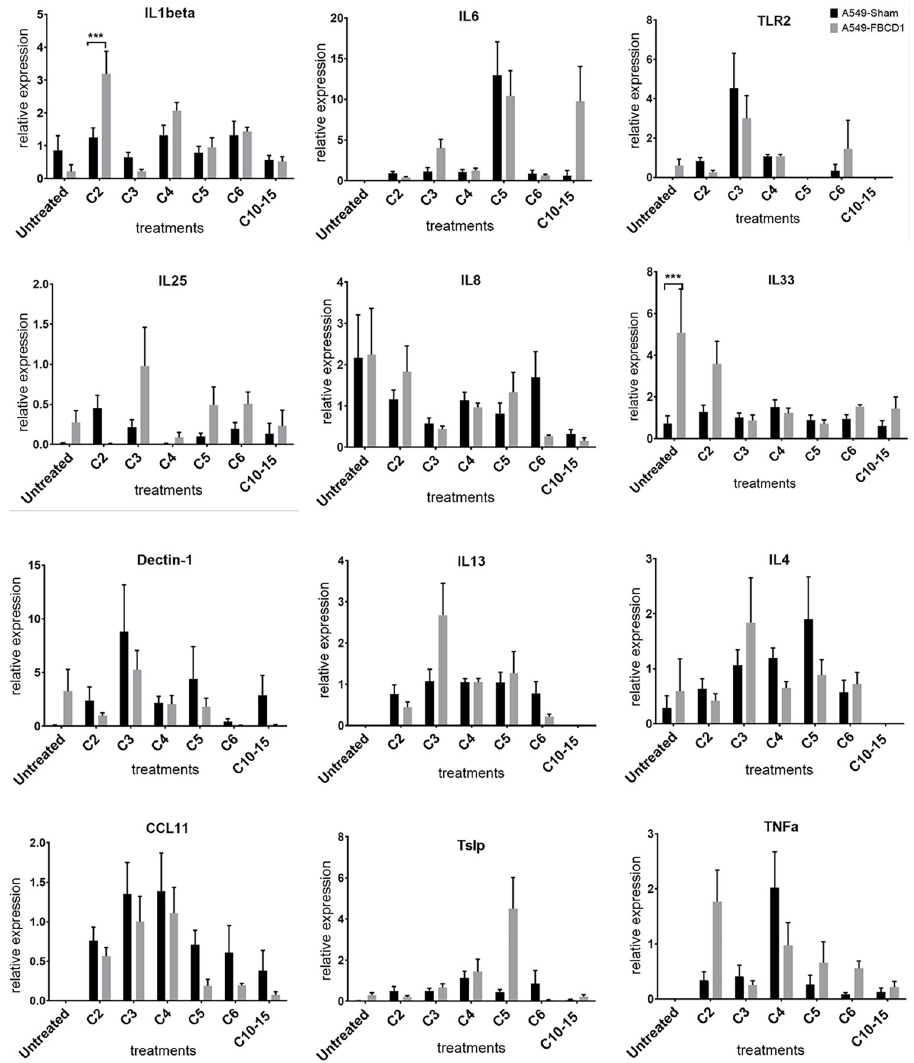
Fig 1. Cytokine modulation in human lung epithelial cells over-expressing FIBCD1 in response to chitin fragments of different sizes. A549-Sham transfected cells are used as control. Cells stimulated for 6 hours and harvested as described in materials and methods and analyzed by qRT-PCR for expression of indicated cytokines using ΔΔ Ct method. Data are a summary of two-three experiments. n = 12/group. � p < 0.05, �� p < 0.01, ��� p < 0.001, ���� p <